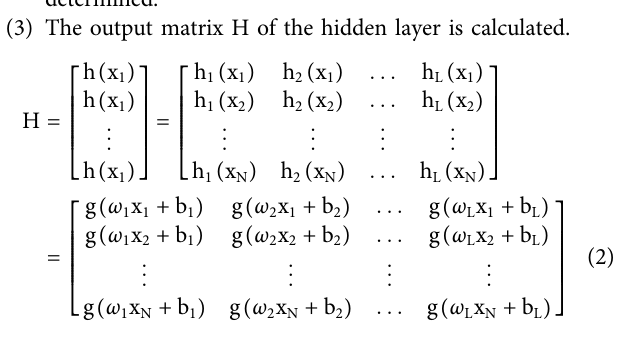
FIGURE 2 | Classic ELM